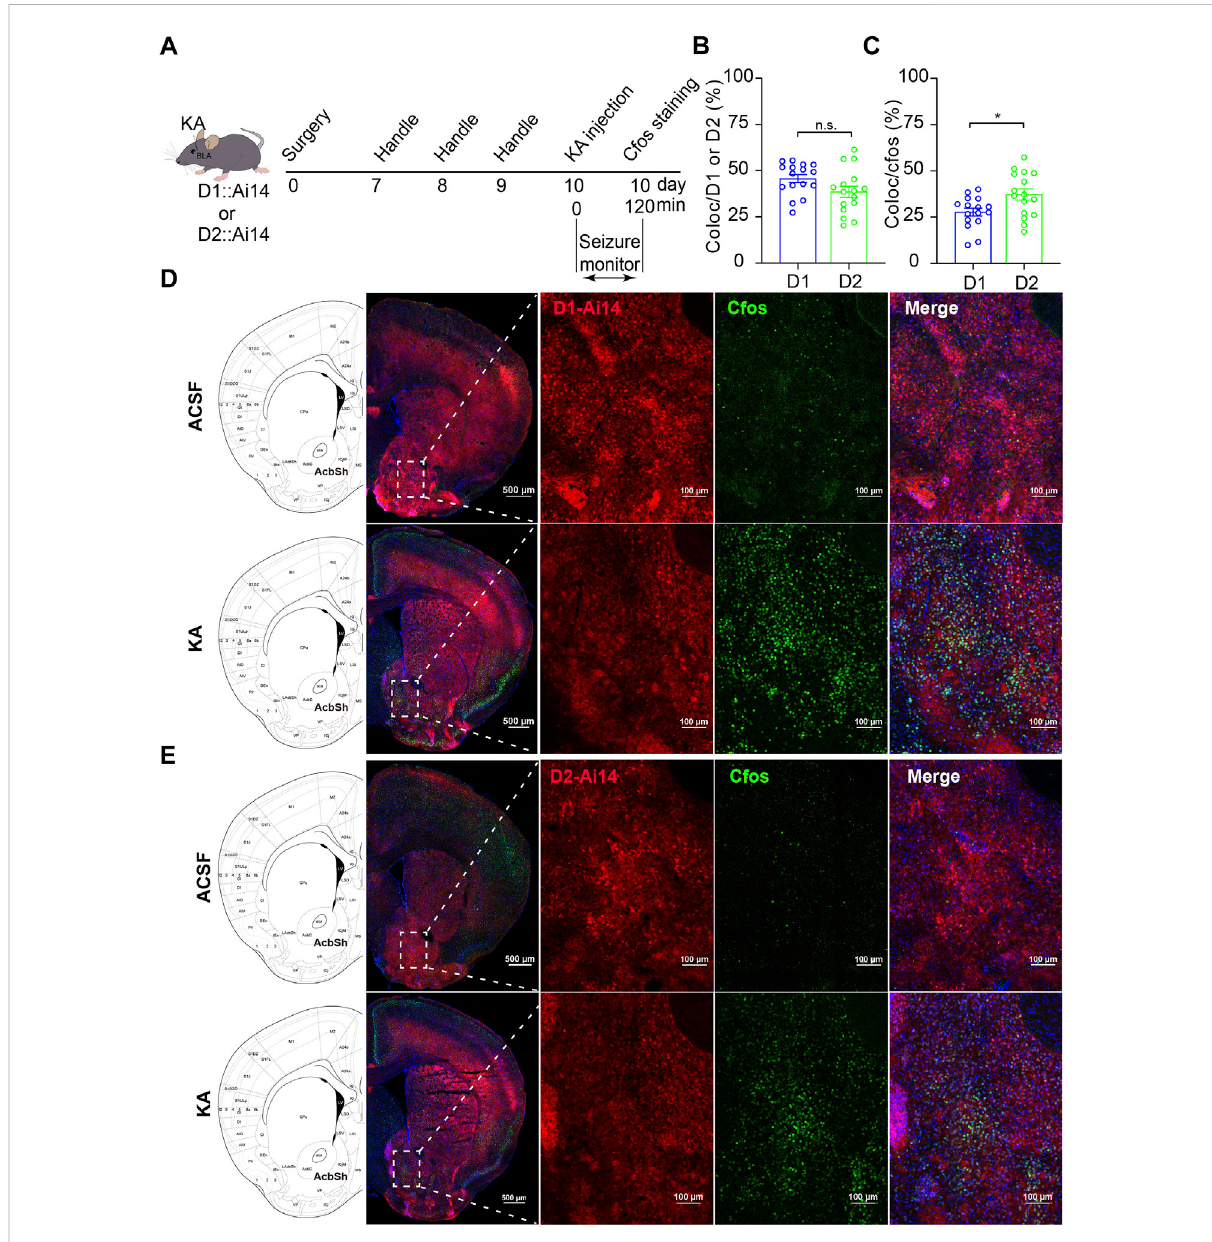
C-fosexpressionoftheMSNsintheNAcshellafterTLEseizures. (A) SchematicdiagramofTLEseizure inductiononD1R-cre::Ai14orD2R-cre:: Ai mouse by intra-basolateral amygdala (intra-amygdala) microinjection of KA. (B) Quanti fi cation of the percentage of c-fos + cells in D1R-MSNs or D2R-MSNs (tdTomato + fromAi14)intheNAc shell.Coloc indicatesc-fos + andtdTomato + cells;D1/2indicatestdTomato + D1R-MSNs orD2R-MSNs. D1 group: n = 16 slices from two mice; D2 group: n = 16 slices from two mice; p > 0.05, Student ’ s unpaired t test. (C) Quanti fi cation of